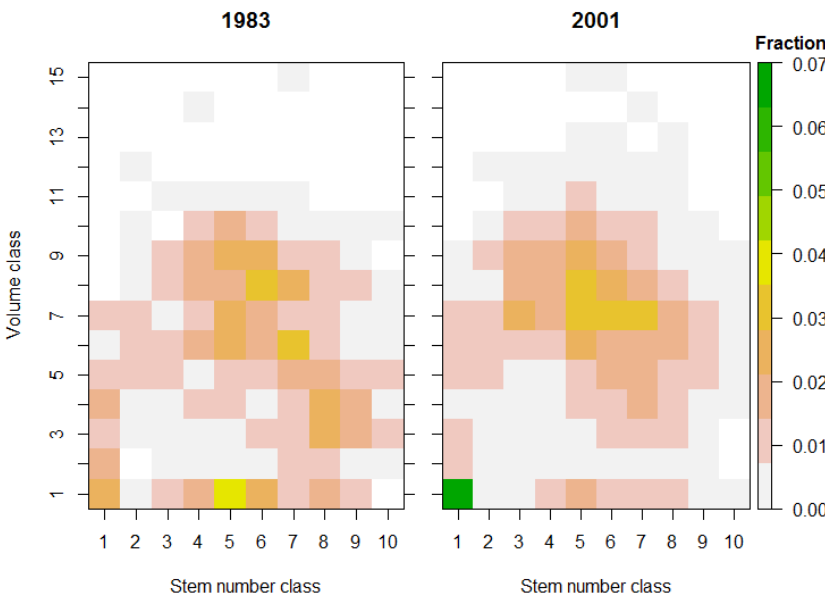
Figure 4. The distributions of areas into the volume and stem number classes for elevation class 1 (Norway spruce) at the initial states “1983” (left) and “2001” (right) illustrated by fractions of the total